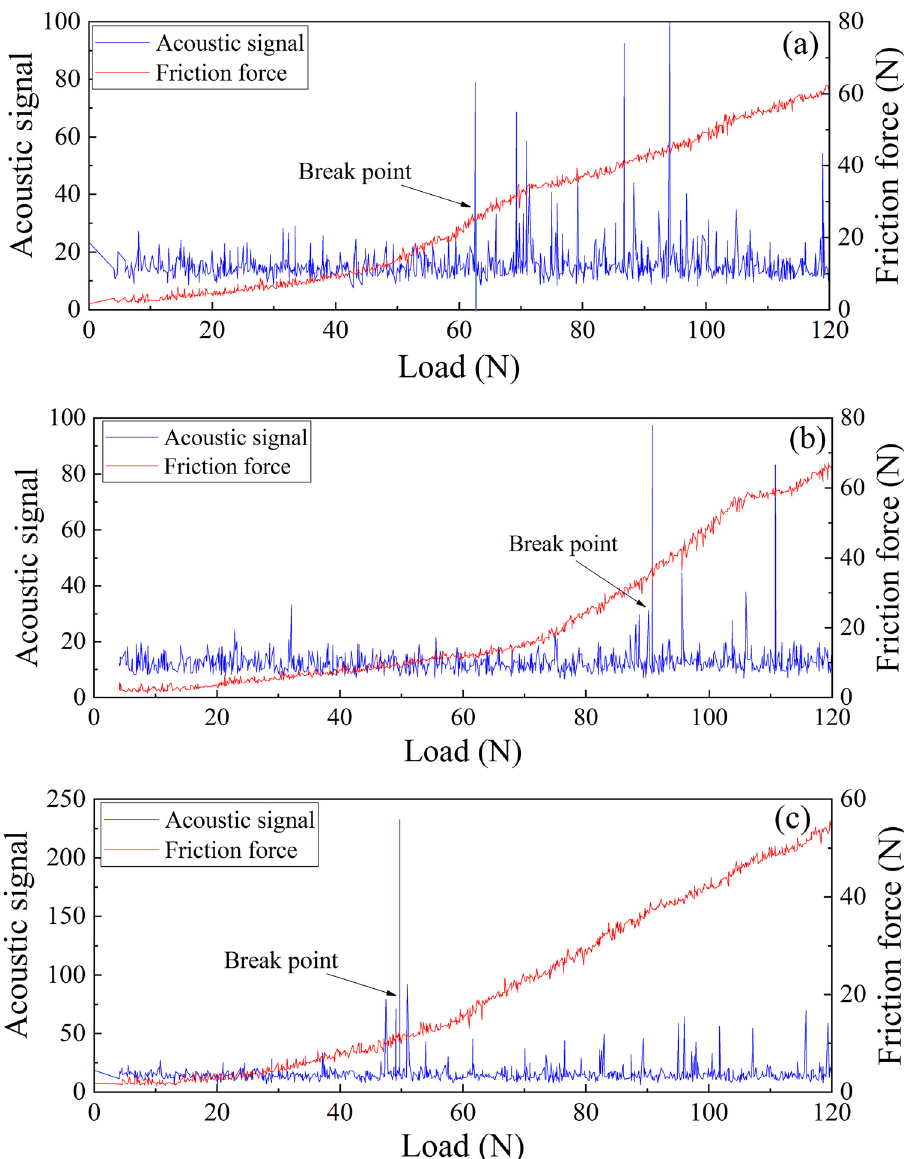
Figure 5: Acoustic wave and tangential friction varying with the applied load for various coatings: ( a ) TiN coating, ( b ) TiAlN coating, ( c ) TiAlCrN